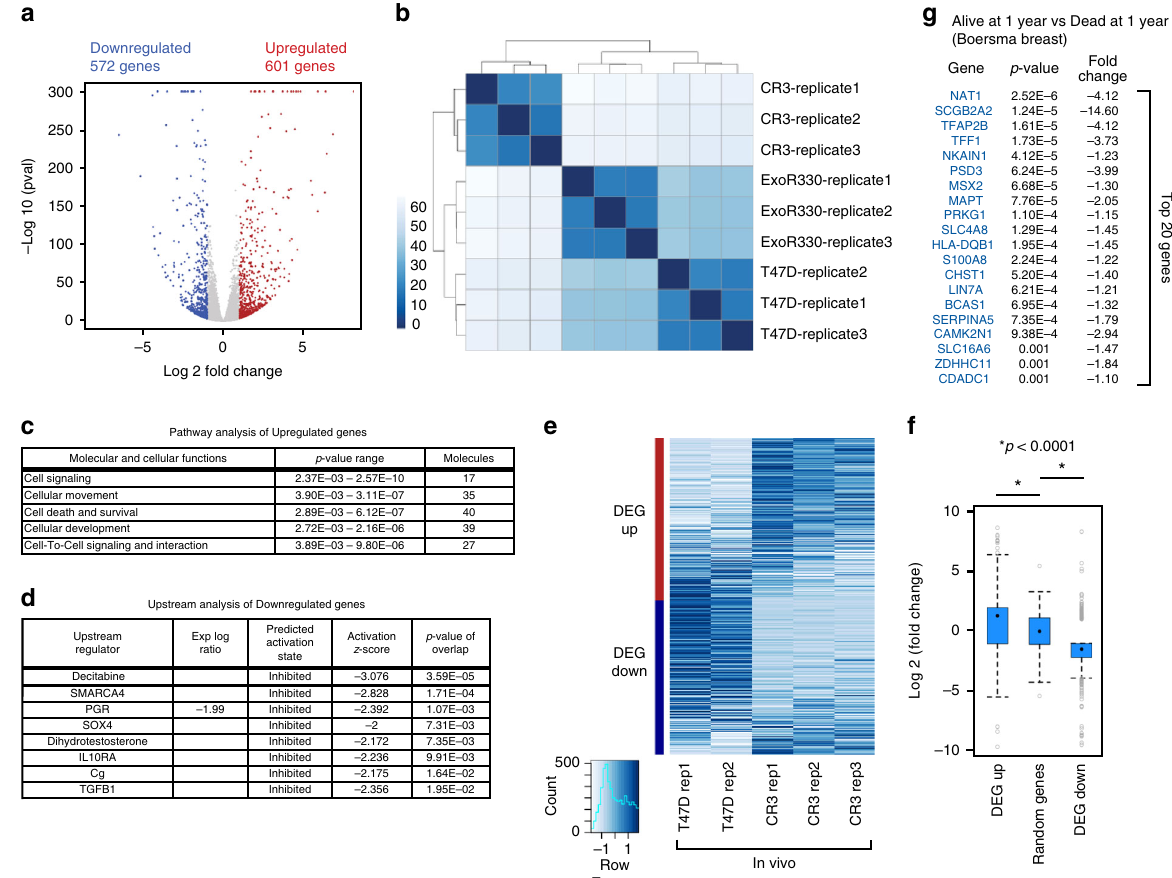
Fig. 3 R330fs mutation reprograms the luminal transcriptional program in breast cancer cells. a Volcano plot displaying the differentially expressed genes between control and GATA3-mutant (CR3) cells. Upregulated genes in CR3 cells are highlighted in red, and downregulated genes are highlighted in blue. Genes with -log 10 p -values > 300 are all plotted at 300 on the ordinate. b Clustered heatmap showing expression patterns in T47D, CR3 and ExoR330fs cells from three biological replicates. The scale indicates Euclidean distance. c The top molecular and cellular function related pathways. The IPA (Ingenuity Pathway Analysis) analysis was conducted by using top 100 upregulated genes (ranked by fold changes), and the top 5 pathway categories are presented. d The upstream regulators predicted by the IPA (QIAGEN) of downregulated genes are listed. Progesterone receptor was identi fi ed as one of the downregulated factors in CR3 cells. e Heatmap showing the row-scaled FPKM values of the in vivo RNA-seq data. The differentially expressed genes identi fi ed by the in vitro RNA-seq shown in a are categorized into upregulated and downregulated gene groups. f Box-and-whisker plots showing relative fold changes in each category. Random genes indicate the randomly selected subset of 600 genes that were not categorized as upregulated or downregulated genes. g Top 20 genes identi fi ed by Oncomine concept analysis. Downregulated genes in CR3 cells were used as input gene set for the gene ontology analysis (Oncomine). 84 genes were signi fi cantly downregulated in the tumors from the patients who died at 1 year. Genes are ranked by p